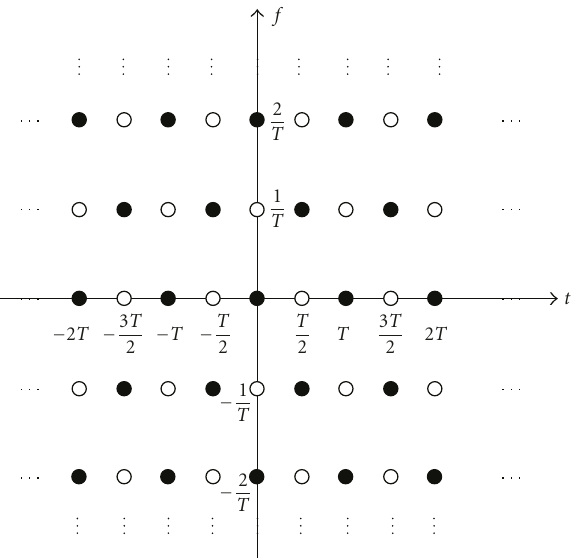
Figure 10: Time-frequency phase space for transmission in SMT.